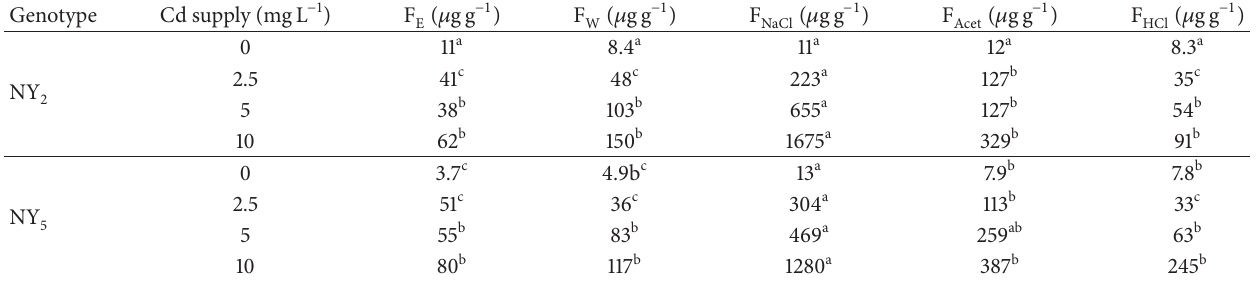
Table 3: Fractionation of Cd in roots of two Jerusalem artichoke genotypes.